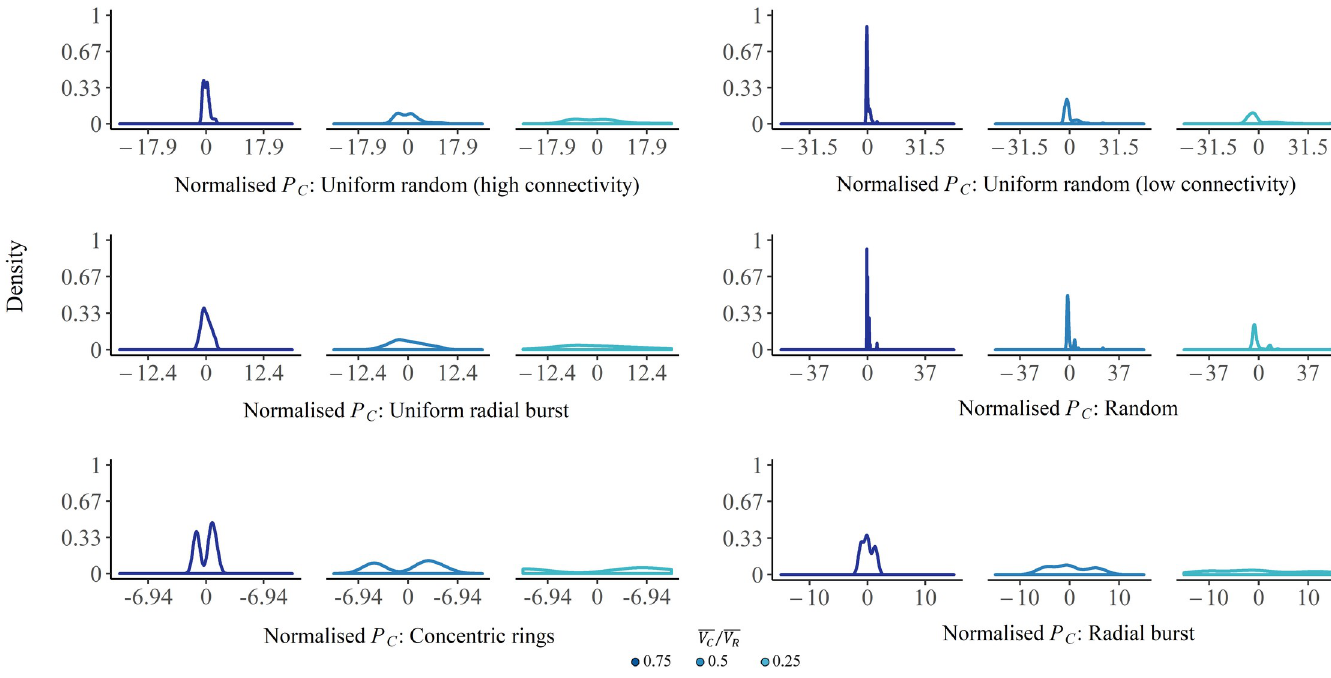
Fig 3. Density plots of normalised consumer final power (PC) for the six example networks, shown over decreasing ratios of mean consumer to mean resource potential, V = V . Each plot shows the density for the normalised consumer final power at V C R increased resource flow during the simulation. The data were normalised by subtracting the mean consumer power at each ratio level, and dividing by the standard deviation of consumer power at V = V = 0.75, such that the width of the first subplot for each network is one standard deviation. C R